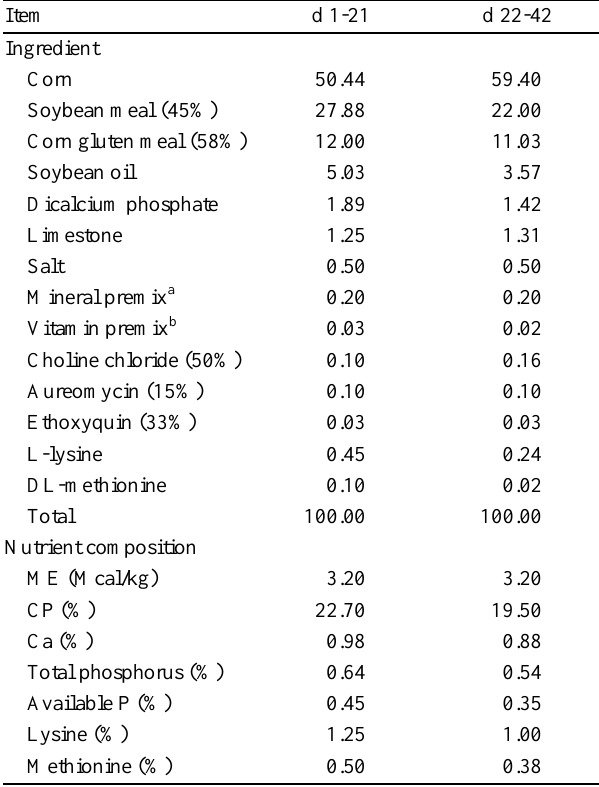
Table 1. Composition of experimental